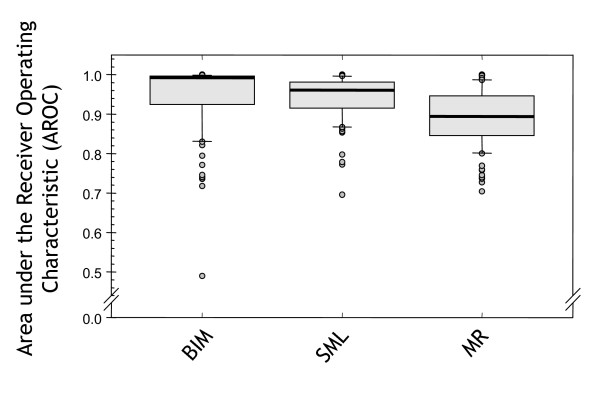
QTL profile accuracy on simulated data. Accuracy of different methods of classifying individual markers as linked to synthetic QTL on 100 simulated datasets. Results of genome profiles obtained using BIM, SML, and MR on 100 simulated datasets. The y-axis here is the Area under the Receiver Operating Characteristic (AROC). The 0.5 level indicates random performance and 1 indicates perfect performance.